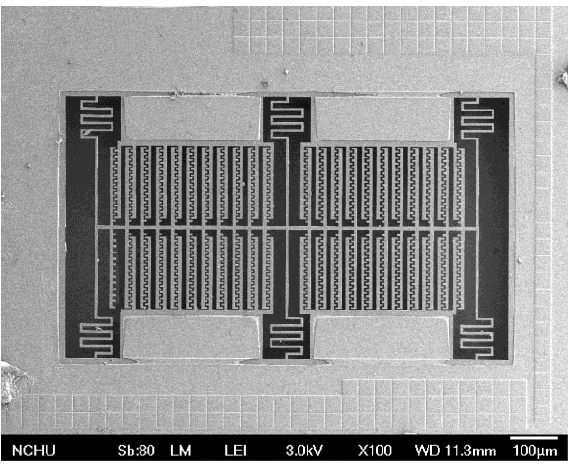
Figure 9. SEM image of the magnetic sensor.